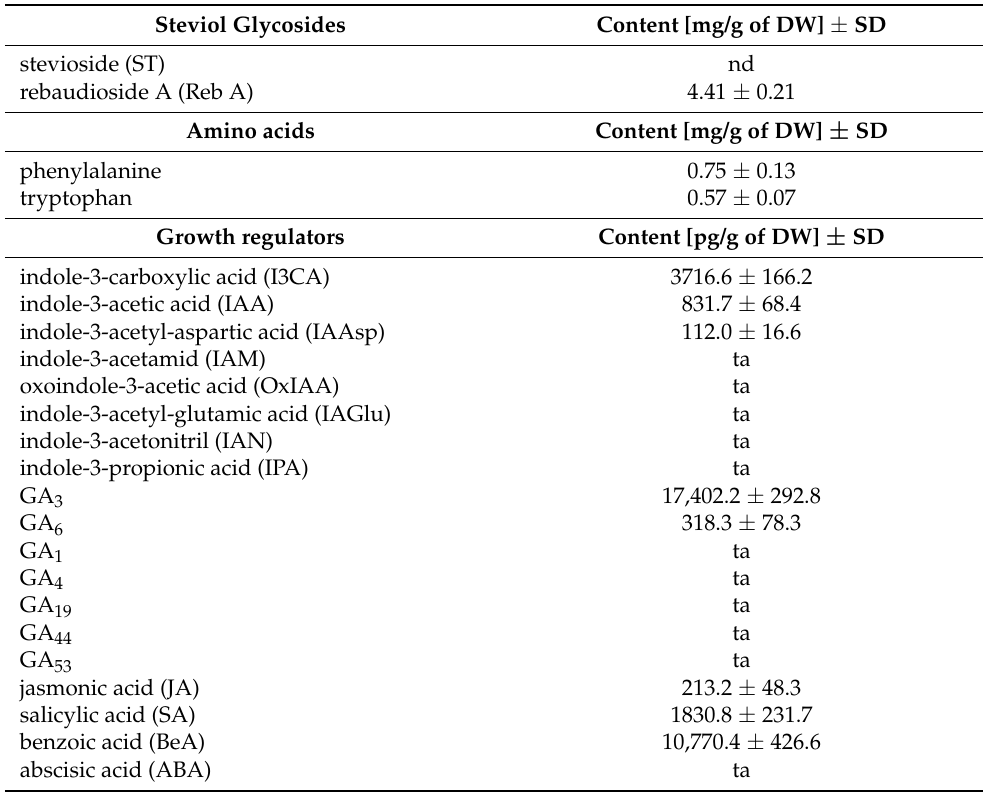
Figure 5. RP-HPLC chromatograms of the stevioside ( A ), rebaudioside A ( B ) standards, and steviol glycosides fraction extract from the SRS89 strain of Pantoea vagans ( C ). Single ion [M+Na] + monitoring (SIM) chromatogram of bacteria sample ( D ) and pure rebaudioside A standard ( E ) separated in HILIC mode. Table 3. Steviol glycosides, amino acids and growth regulars content in Pantoea vagans strain SRS89. The results are the means of three replications ( n = 3) ± SD (nd—not detectable; ta—trace